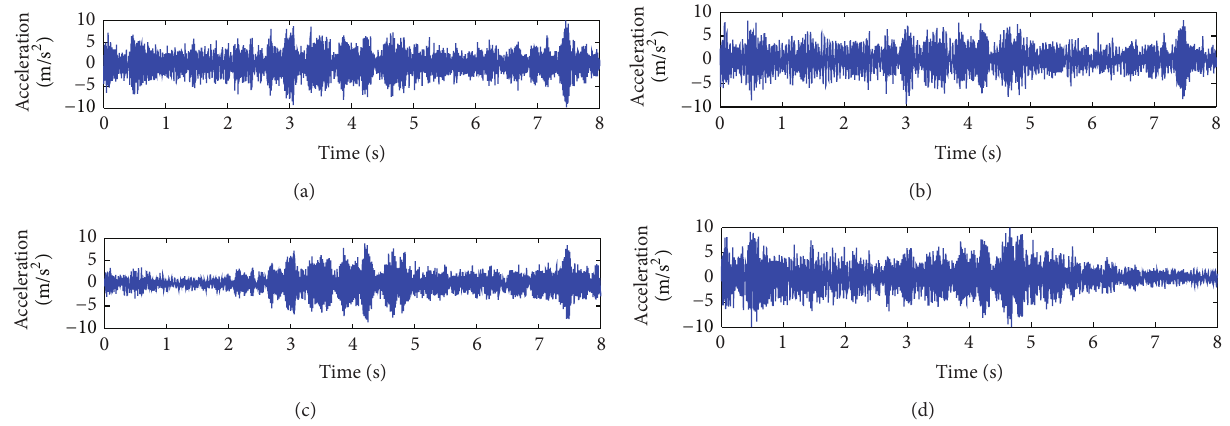
Figure 6: Acceleration responses of (a) Output 1, (b) Output 4, (c) Output 7, and (d) Output 11 of the time-varying structure.